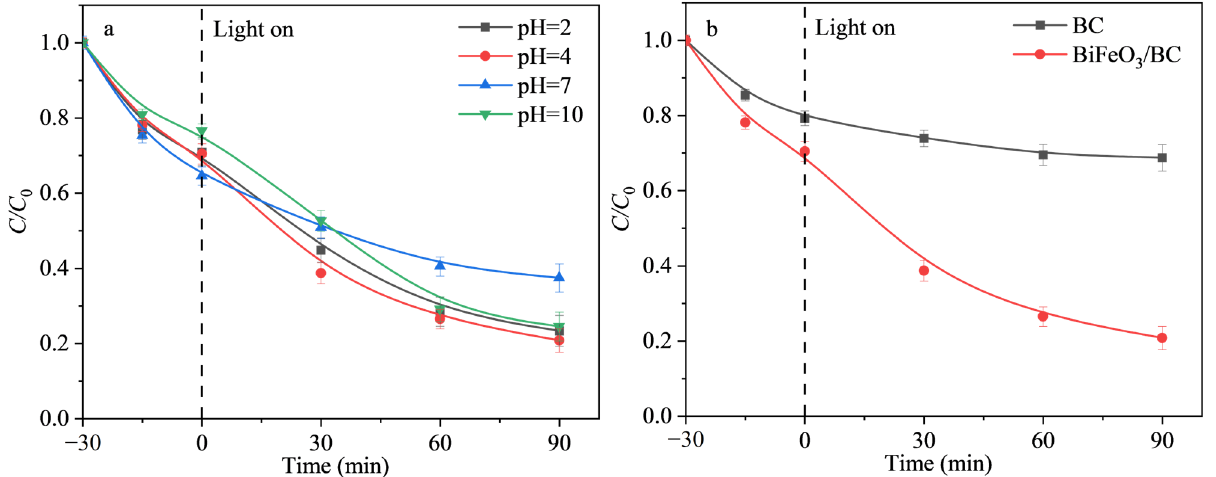
Figure 5. ( a ) Effect of pH on photocatalytic efficiency. ( b ) Comparison of photocatalytic degradation capacity of BC and BiFeO 3 /BC at pH = 4 (3 replicates; dosage of BiFeO 3 /BC or BC = 0.5 g; C 0 (TCH) = 30 mg/L).